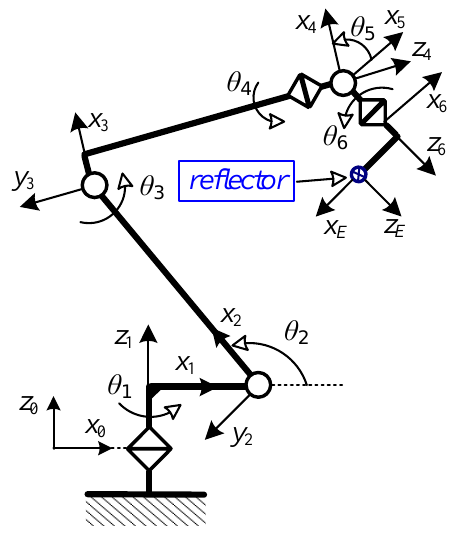
Figure 5. Schematic of robot HA-06 and attached link frames.